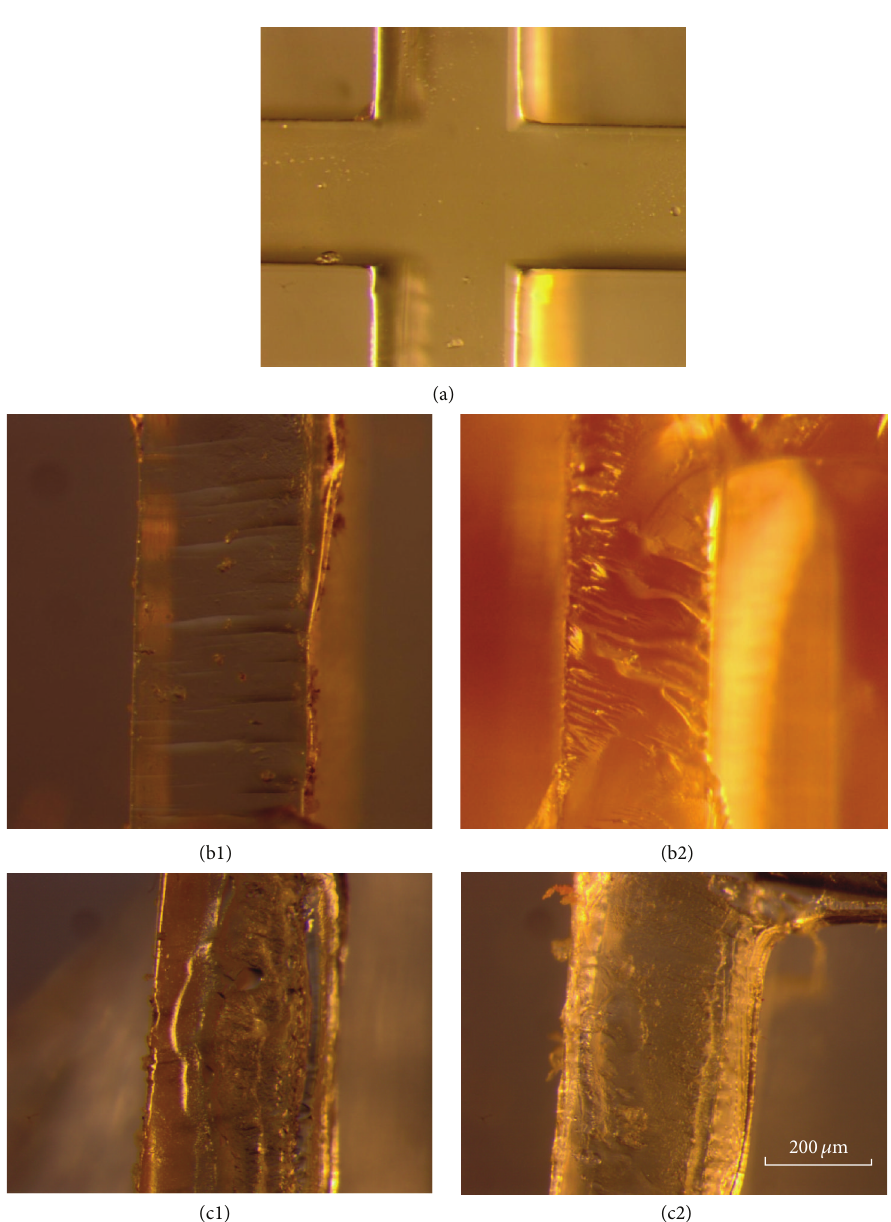
Figure 7: Interface morphology photographs of bonding effect × 20 ((a) microstructure interface before bonding; (b1) tearing interface 1 without treatment at 65 ∘ C; (b2) tearing tnterface 2 without treatment at 65 ∘ C; (c1) tearing interface 1 after treatment at 45 ∘ C; (c2) tearing interface 2 after treatment at 45 ∘